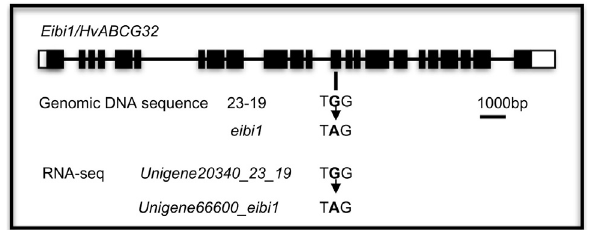
Figure 2 - Identification of eibi1 mutation by RNA-Seq. Unige- ne20340_23-19andUnigene66600_ eibi1 wereassembledfromRNA-Seq of wild-type 23-19 and mutant eibi1 , respectively. The SNPs are indicated by arrows.